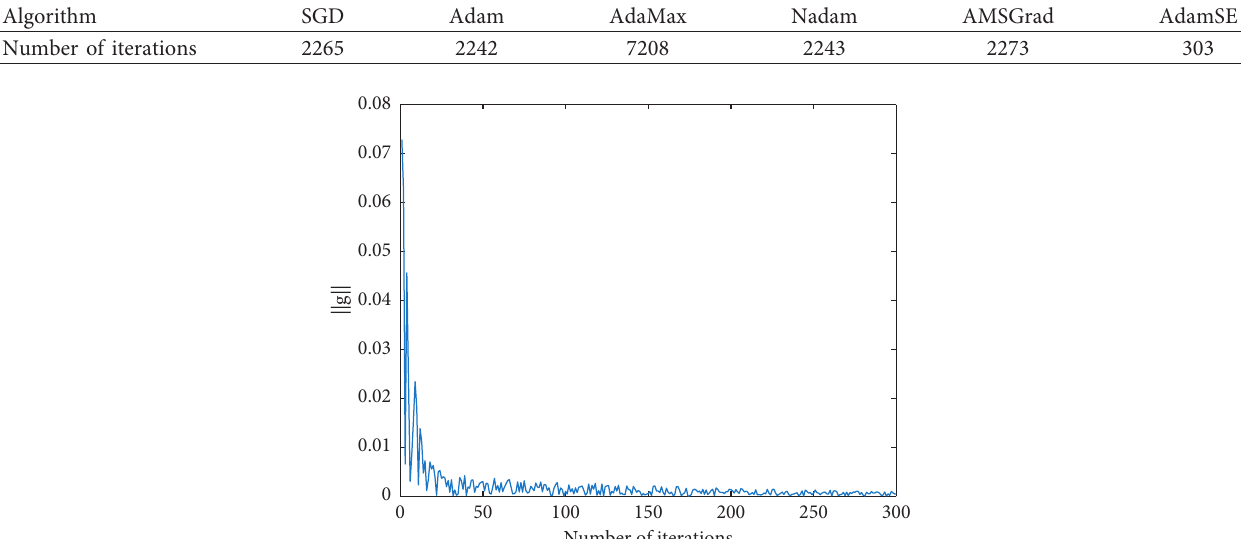
Figure 1: Convergence behavior of SGD algorithm for the first 300 of 2265 iteration numbers.